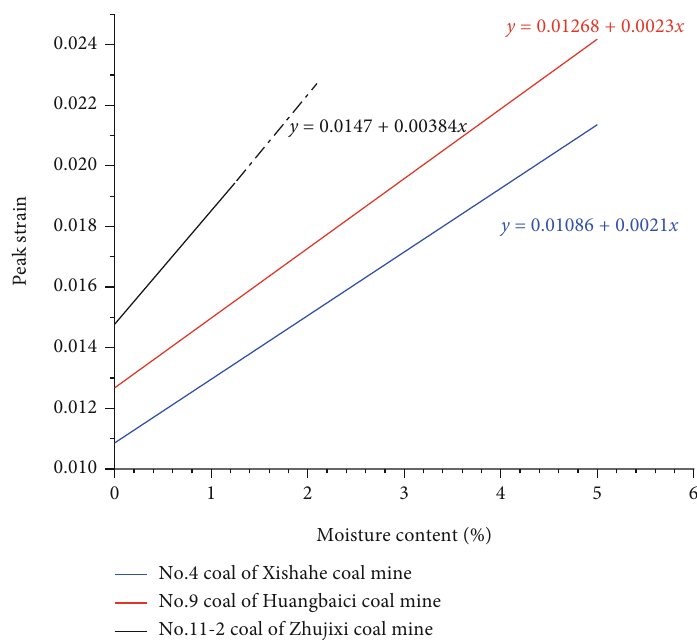
Figure 9: Relationship between peak stress and moisture content of coal